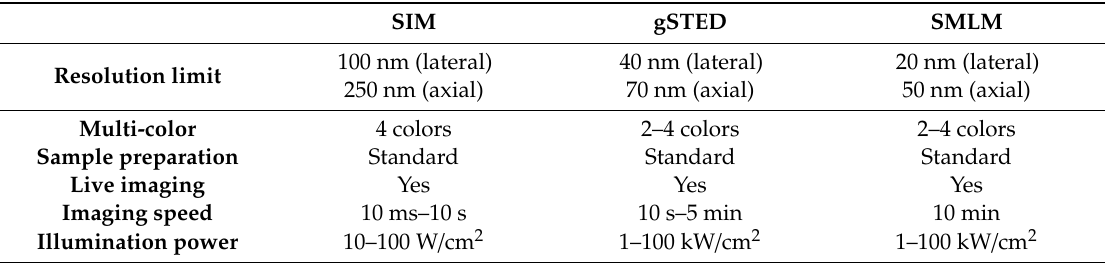
Table 1. Overview and direct comparison of the key parameters of SIM, gSTED, and